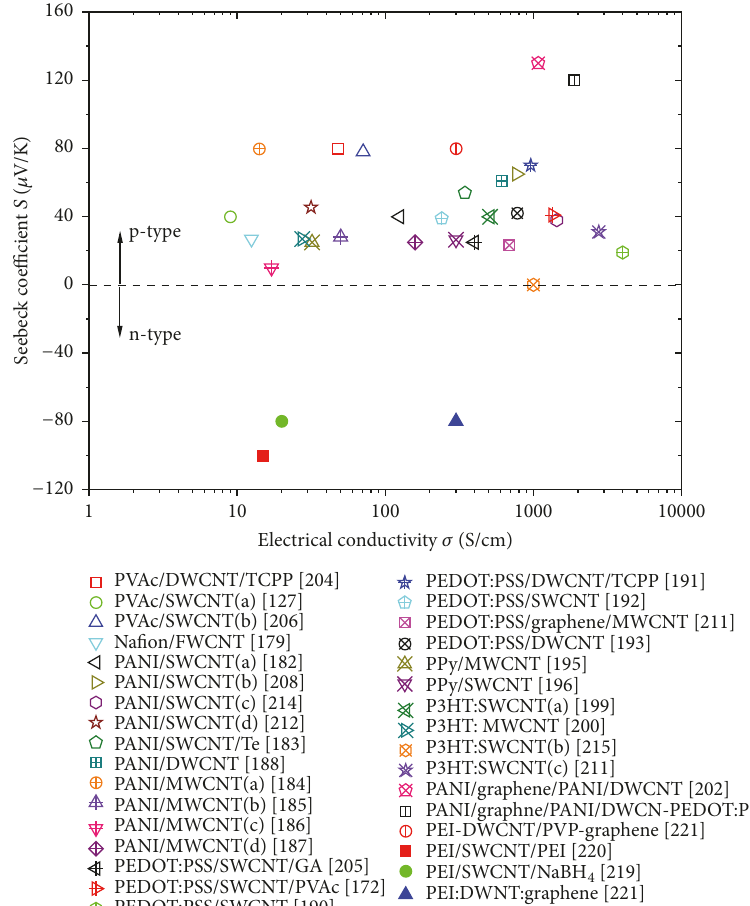
Figure 11: Seebeck coefficient and electrical conductivity of composites of CNT or graphene with polymers measured in previous studies.